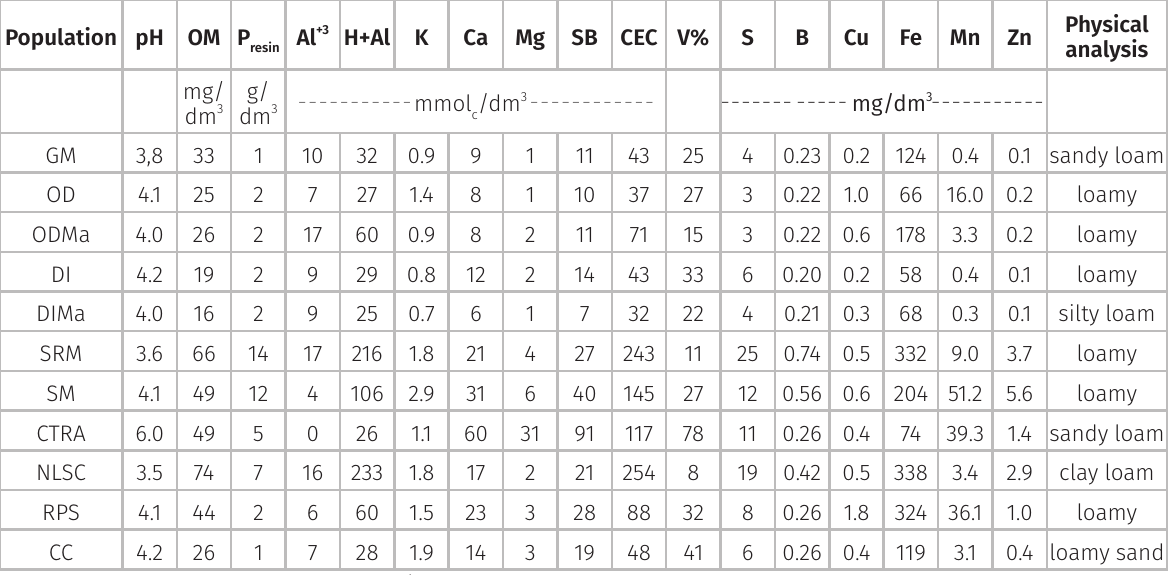
Table II. Physical and chemical properties of soils in the regions of occurrence of natural populations of Lychnophora pinaster , State of Minas Gerais,